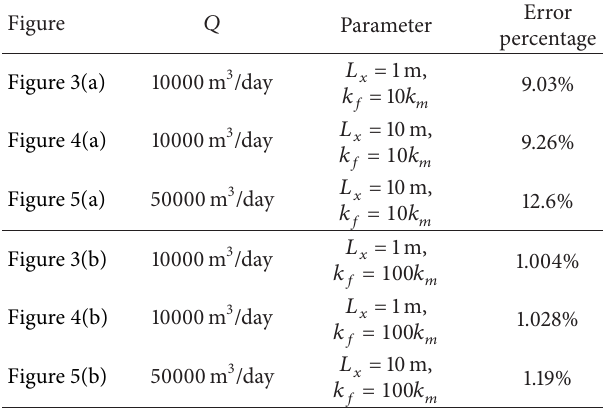
Table 4: Error percentage of BHP without flow between wellbore and